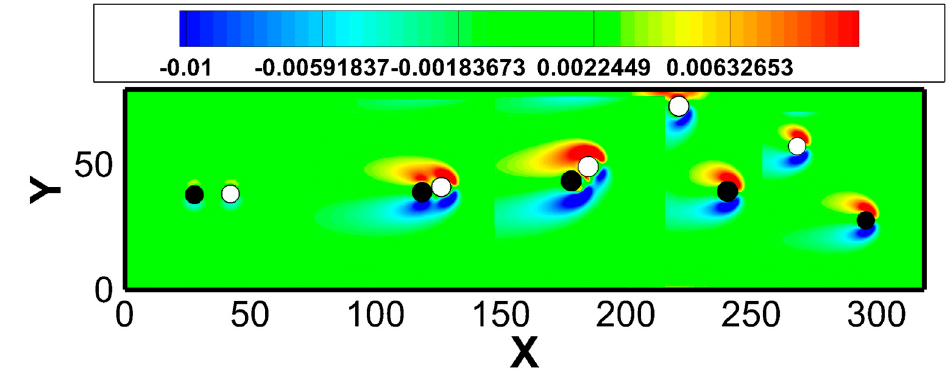
Figure 8. The overall trajectory of the particles with time change accompanied by the vorticity.